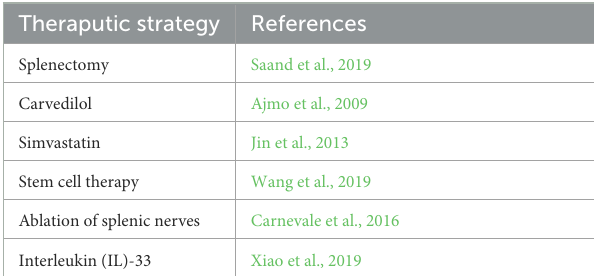
TABLE 1 Neuroimmune regulation targeting